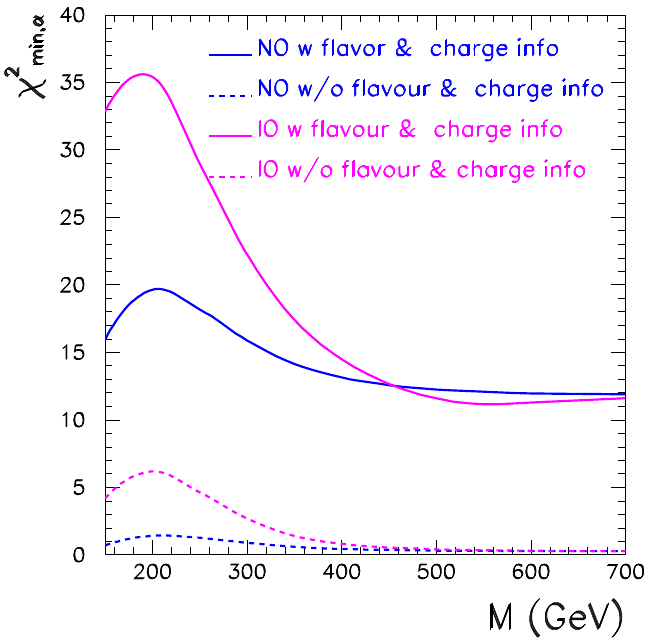
Figure 5 . Triplet mass dependence of the (cid:31) 2 functions of the analysis of pp ! ll 0 jj(cid:23)(cid:23) events with l; l 0 being either e or (cid:22) of either charge observed in the LHC Run-I in ATLAS [22] when analyzed in the context of MLFV Type-III see-saw model. The full lines correspond to the likelihood function constructed including the full information given on (cid:13)avour and charge of the (cid:12)nal states (see eq. (4.1)) while the dashed lines are obtained from the analysis of the total data summing over charge and (cid:13)avour. The triplet couplings have been marginalized within the ranges allowed at 95% CL by the neutrino oscillation data analysis in ref. [35] for NO (blue lines) and IO (purple lines) and for any value of the Majorana phase (cid:11)